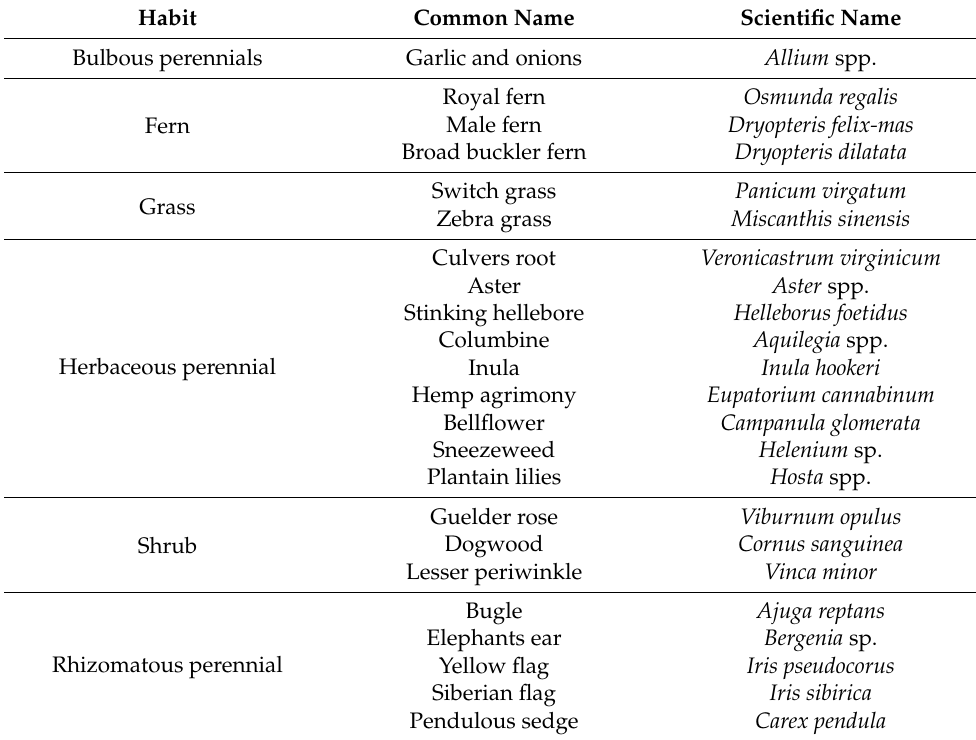
Table 1. Selected suggestions for planting in UK conditions